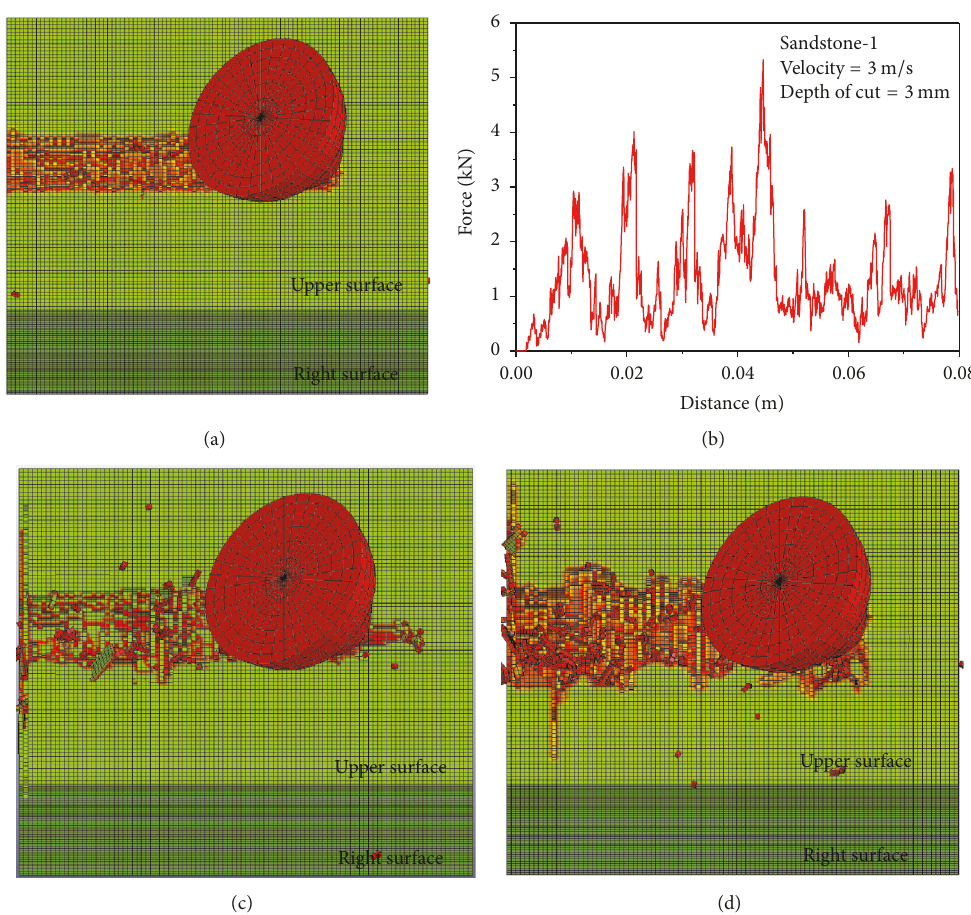
Figure 7: The cutting results with a cutter speed of 3 m/s for sandstone-1: (a) cutting results with a cutting depth of 3 mm, (b) the variation in the cutting force with a cutting depth of 3 mm, (c) the cutting results at a cutting depth of 4 mm, and (d) the cutting results at a cutting depth of 5